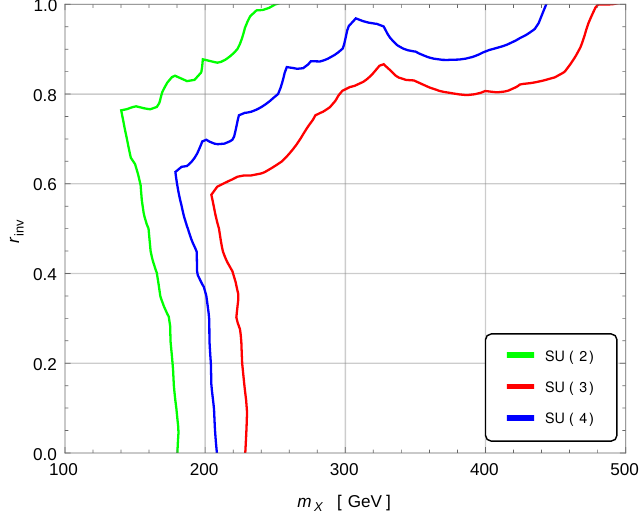
Figure 8. Summary of the bounds for case III for G corresponding to SU( N ). The bounds at low r inv come from measurements of the di(cid:11)erential WZ cross section and those at large r inv from refs. [54] and [55]. The coe(cid:14)cients were set to y F